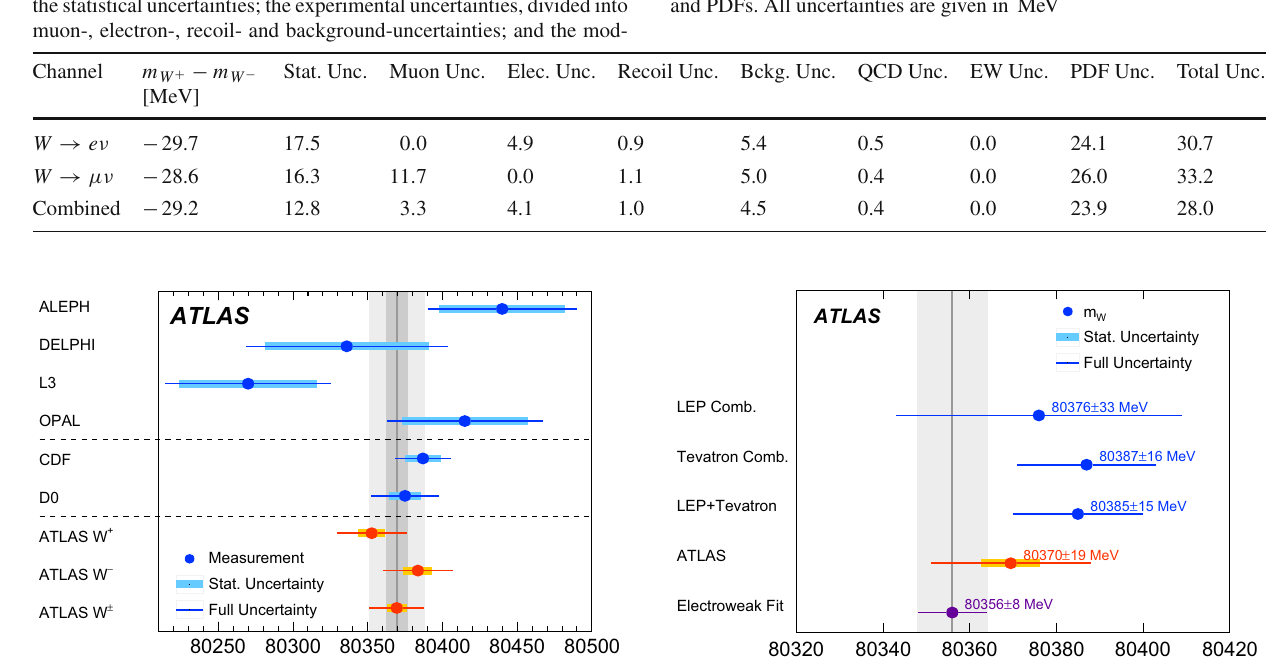
elling uncertainties, separately for QCD modelling including scale vari- ations, parton shower and angular coefficients, electroweak corrections, and PDFs. All uncertainties are given in MeV